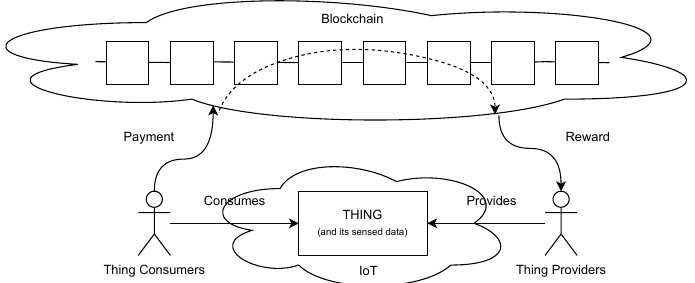
Figure 1. A schematic representation of the reference scenario. Thing consumers pay to use things or the data they gather. They are entitled to do that only if their payment was recorded in the blockchain. Thing providers get a reward to make their things or data available. The reward is autonomously dispensed by a transaction on the blockchain. Payment and reward might be two sides of the same transaction; however, this is not always the